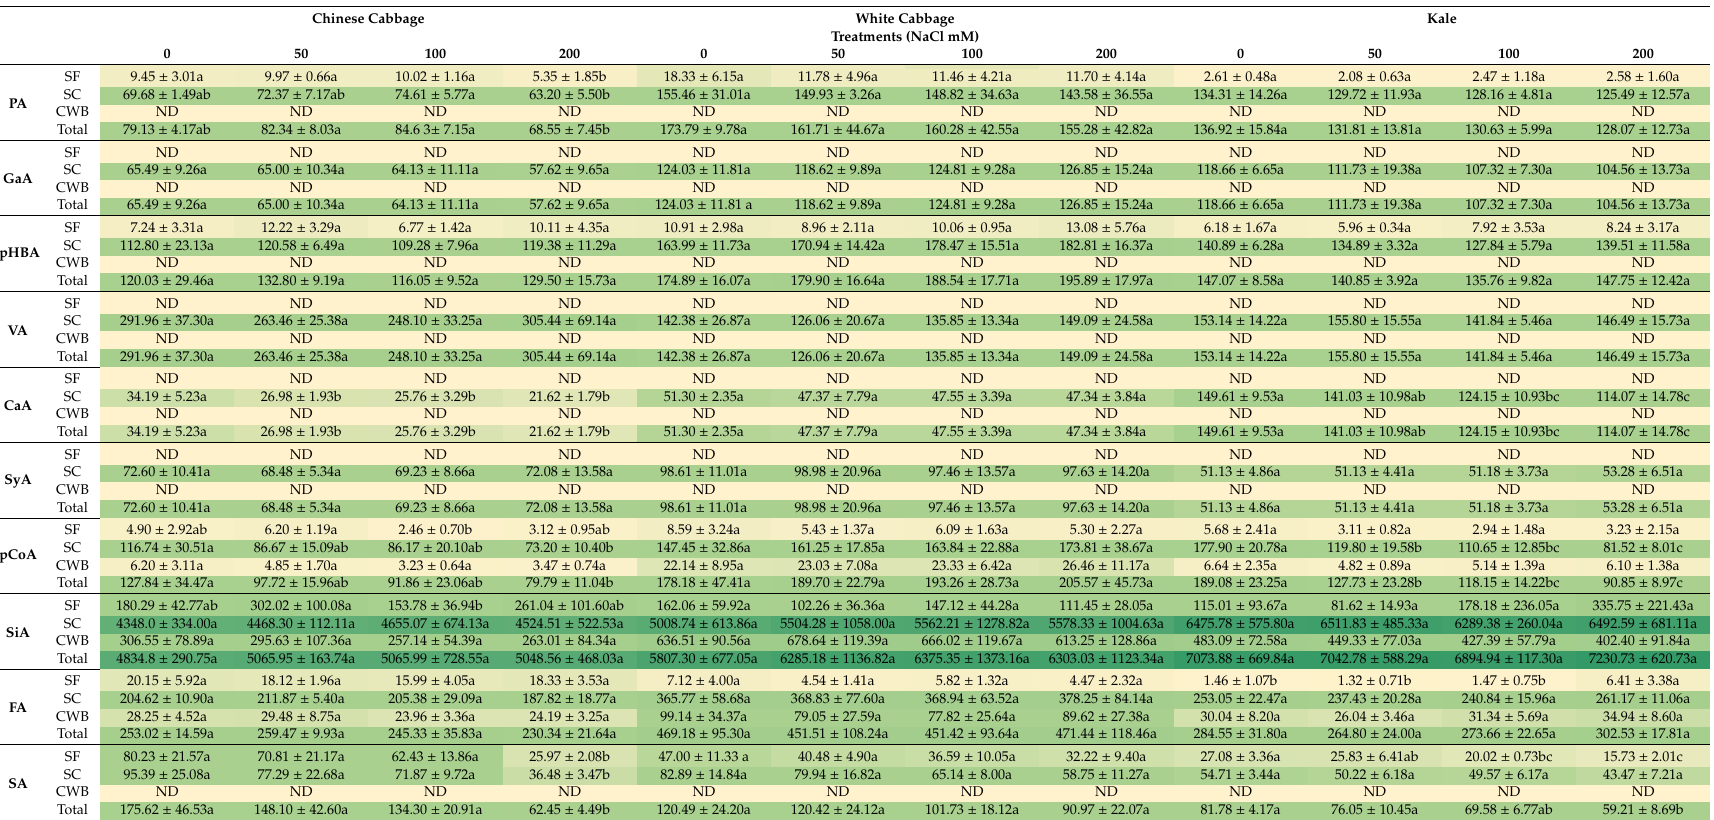
Table 3. Phenolic acids contents (pmol mg –1 dw), soluble free (SF), soluble ester-conjugated (SC), and cell wall-bound (CWB,) measured in seedlings of Chinese cabbage, white cabbage, and kale upon salt treatments (0–200 mM NaCl). Color gradation from light yellow to dark green comparatively represents values among species from the lowest to the highest. ND-not